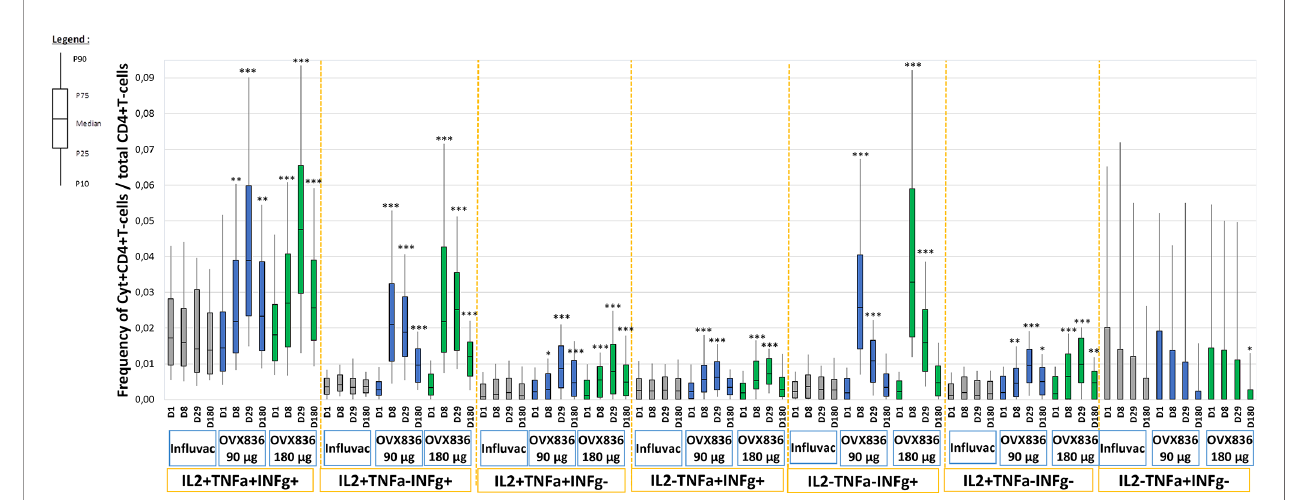
FIGURE 2 | Frequencies of nucleoprotein (NP)-speci fi c CD4+ T-cells identi fi ed in vitro as expressing the combinations of cytokines: IFN g , IL-2 and TNF a at pre- vaccination, Day 1 (D1), Day 8 (D8), Day 29 (D29) and Day 180 (D180) in the three treatment groups (In fl uvac Tetra ™ , OVX836 90µg and OVX836 180µg; modi fi ed intention-to-treat cohort). Results are shown as box plot with the horizontal central bar corresponding to the median, limits of the box corresponding to percentiles 25 and 75, and vertical bars corresponding to percentiles 10 and 90. Intragroup differences: *p<0.05, **p<0.01 and ***p<0.0001; paired t tests versus baseline. Main intergroup differences (global ANOVA with p value <0.05 at each timepoint and post-hoc t tests between OVX836 90 µg and OVX836 180 µg with p values <0.05) were as follows: - IL2+/TNF a +/IFN g +: Day 8 global p=0.012, Day 29 global p<0.0001, Day 180 global p<0.0001. - IL2+/TNF a -/IFN g +: Day 8 global p<0.0001, Day 29 global p<0.0001 (OVX836 180 µg versus OVX836 90 µg p=0.008), Day 180 global p<0.0001 (OVX836 180 µg versus OVX836 90 µg p=0.026). - IL2+/TNF a